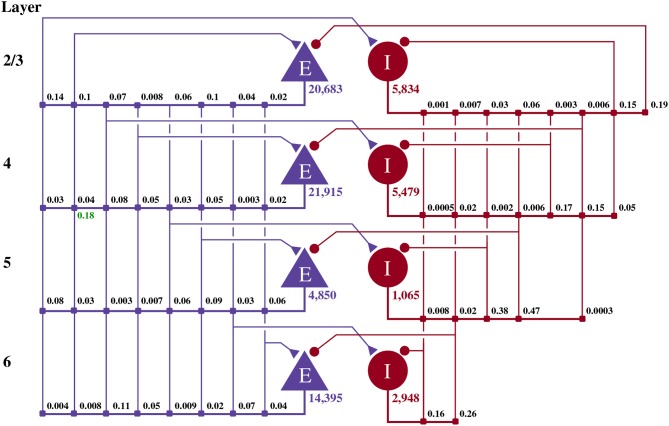
Illustration of the microcircuit model. Blue triangles represent excitatory populations, red circles represent inhibitory populations and the numbers beneath each symbol shows the number of neurons in each population. Connection probabilities are shown in small bold numbers at the appropriate point in the connection matrix. All excitatory synaptic weights are normally distributed with a mean of 0.0878 nA (unless otherwise indicated in green) and a standard deviation of 0.008 78 nA. All inhibitory synaptic weights are normally distributed with a mean of 0.3512 nA and a standard deviation of 0.035 12 nA.